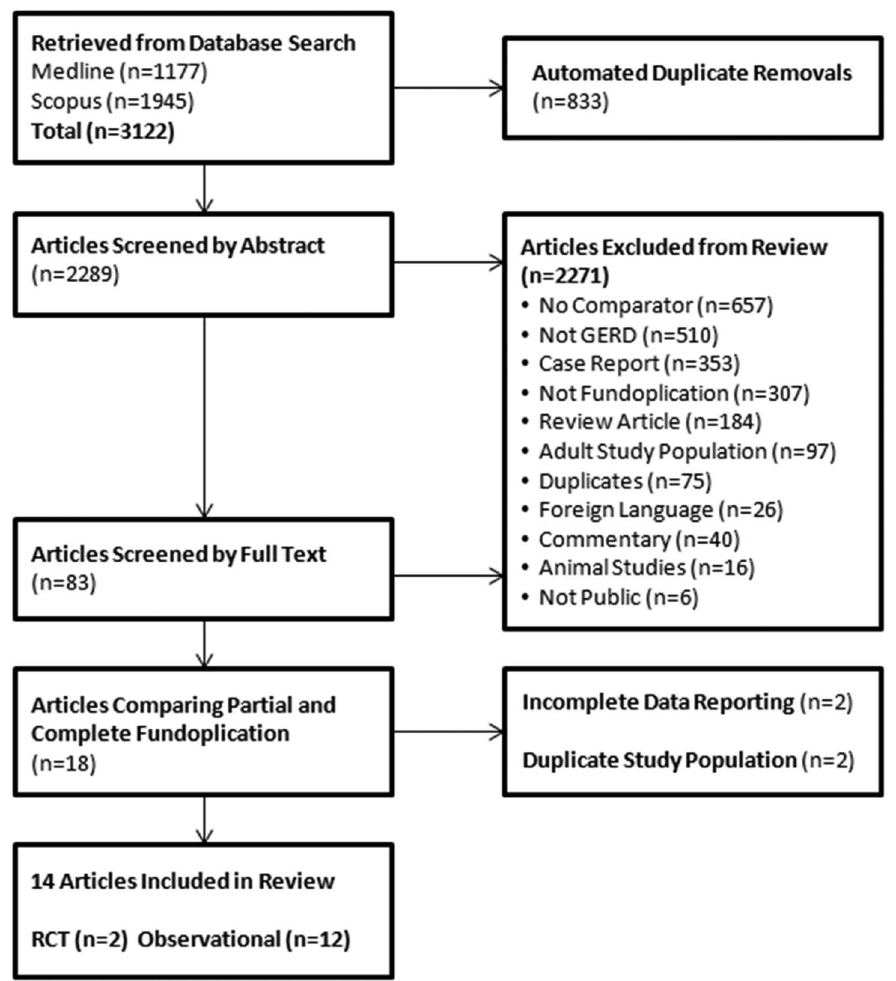
Figure 1. Flow chart of study selection process identifying studies comparing partial and complete fundoplication.